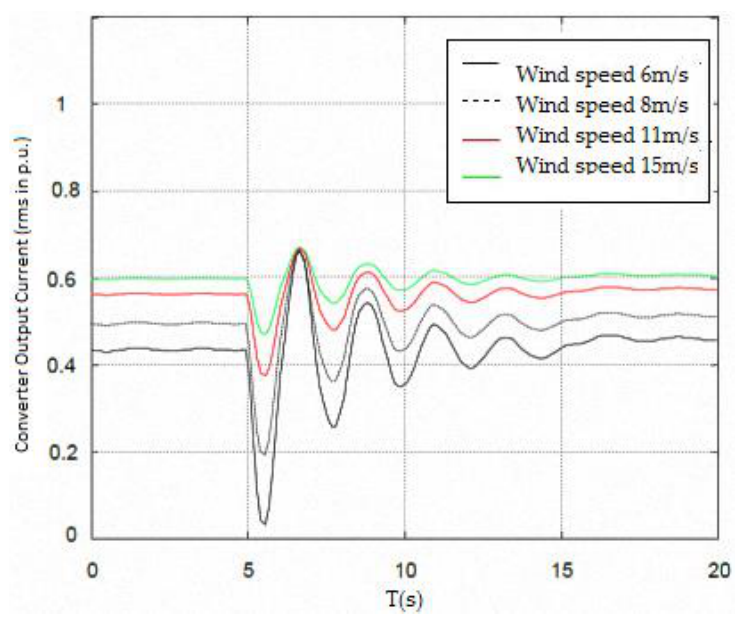
Figure 11. The output converter rms current of DFIG involved in damping control strategy.